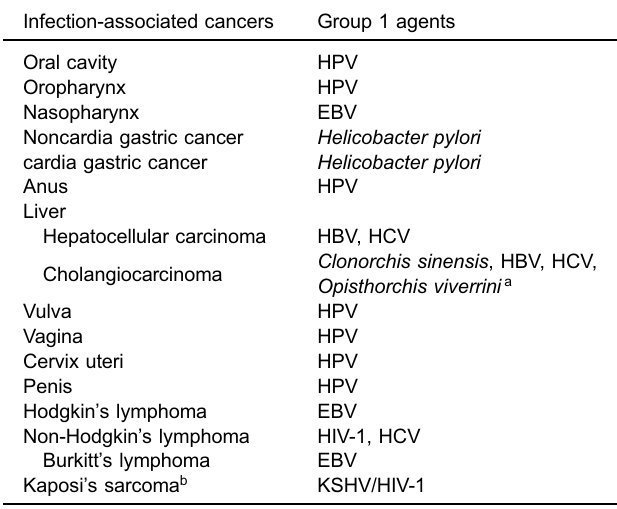
Table 1. List of group 1 carcinogenic biological agents and related cancers Infection-associated